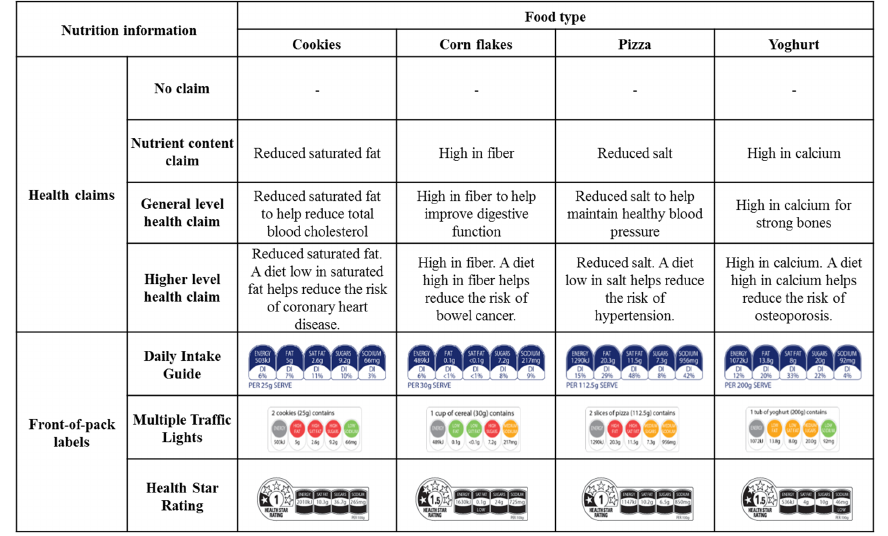
Figure 1. Health claims and front ‐ of pack labels by food type.